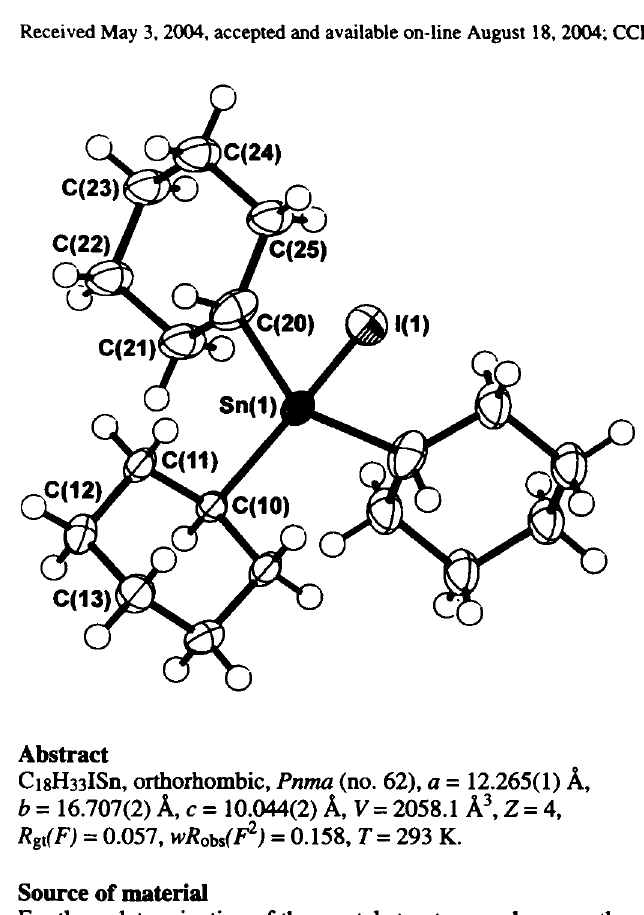
Table 1. Data collection and handling.